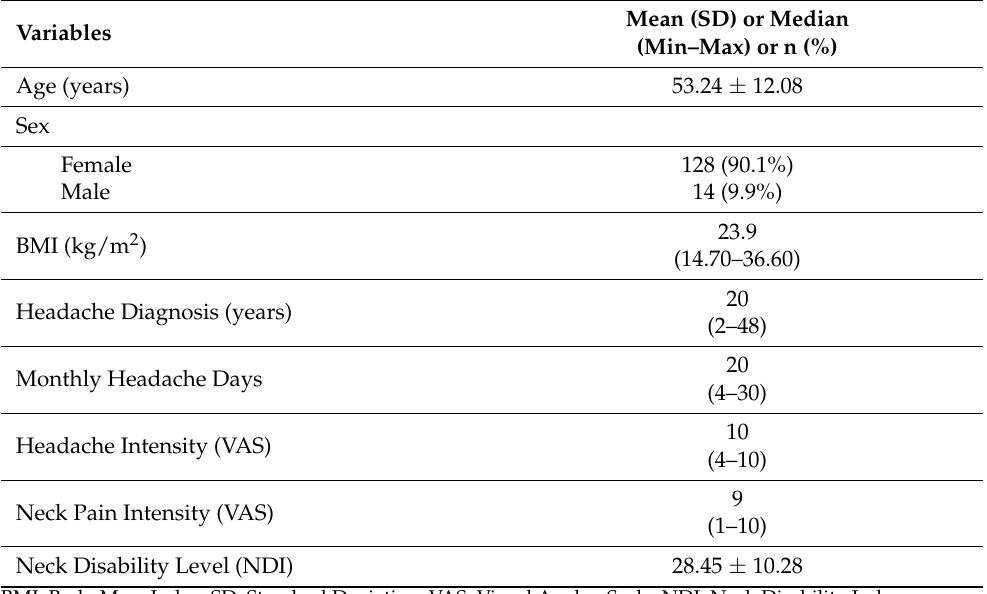
Table 1. The Demographic and Clinic